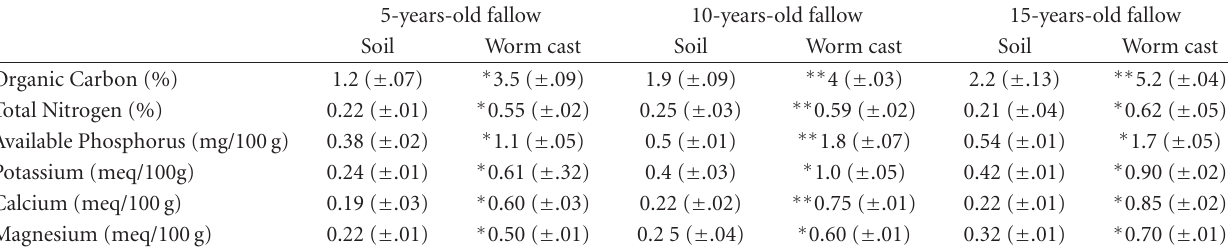
Table 4: Variation in nutrient concentration of earthworm casts and non ingested soils in abandoned agricultural fallows in North East India ( ± SE, n = 5)